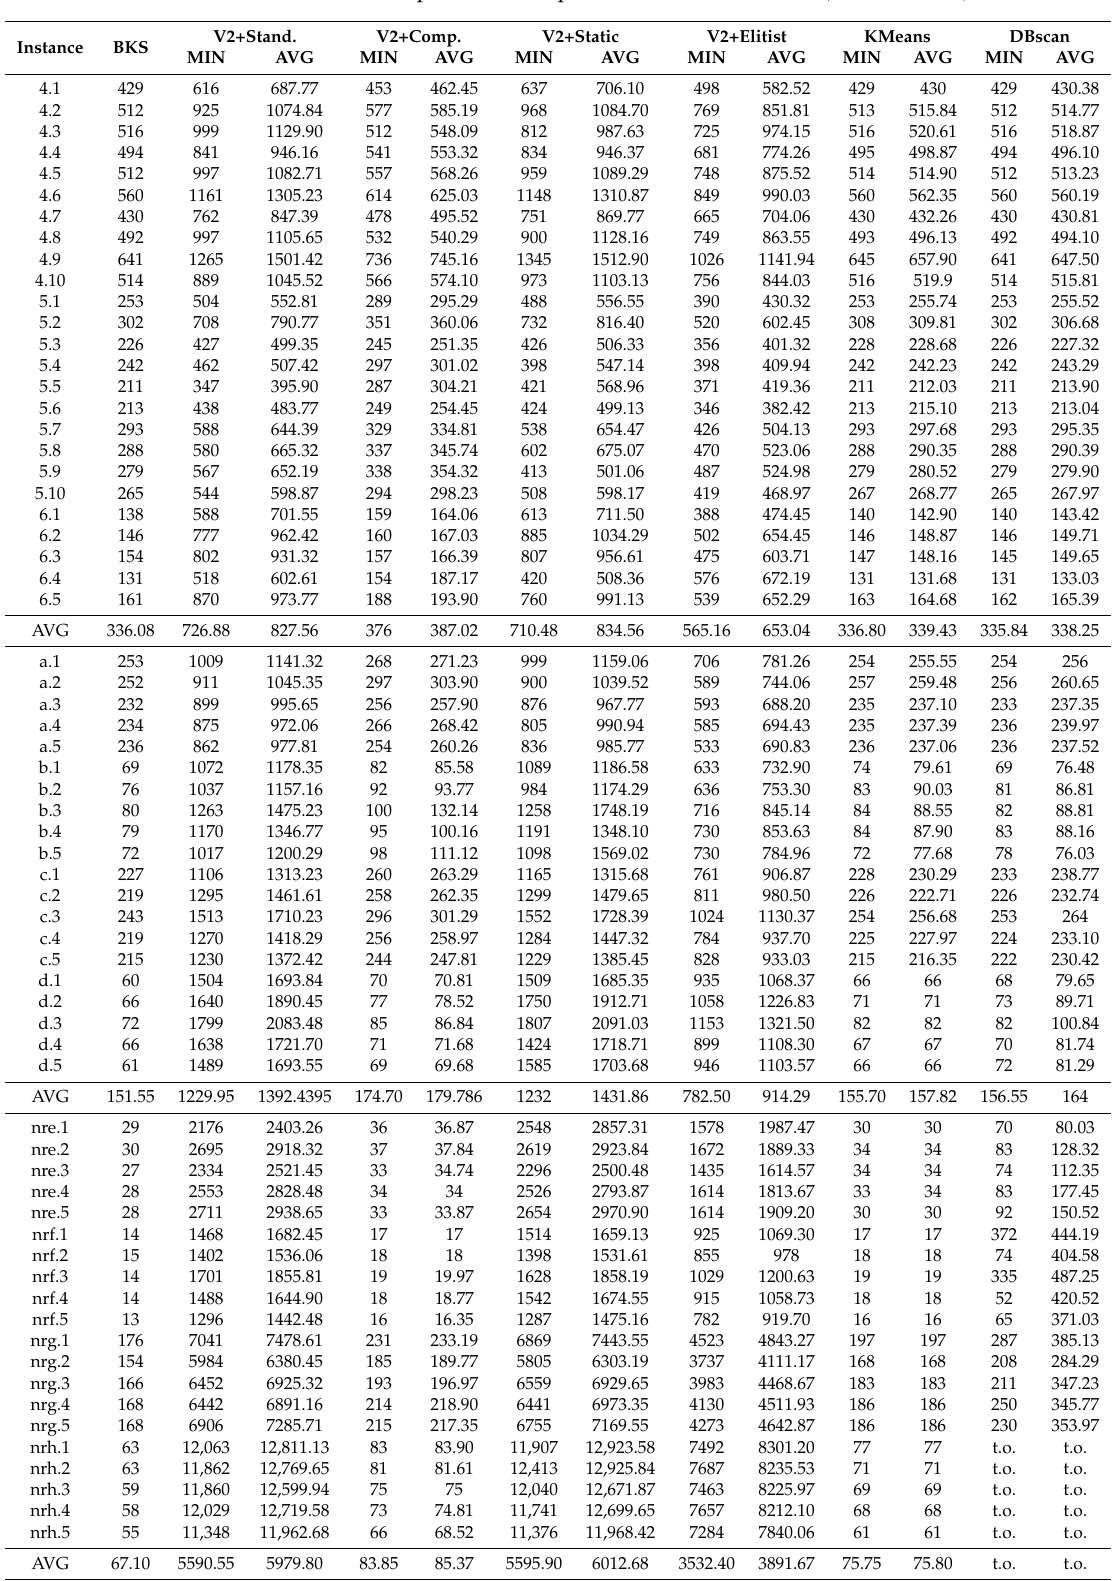
Table A6. CSA/SCP—VShape 2—Two-steps vs. KMeans vs. DBscan (t.o = time